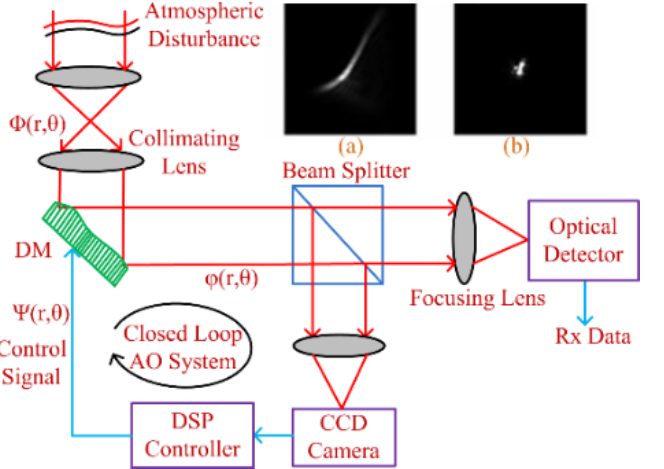
Figure 7. Sensor-less AO system for wavefront aberration correction: inner plot (a) is without AO while (b) is with AO.